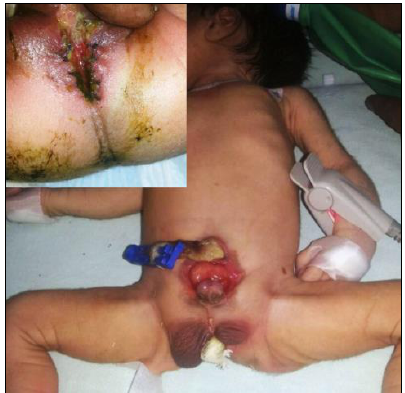
Figure 1: Showing exstrophy of bladder and epispadias. Inset shows low anorectal